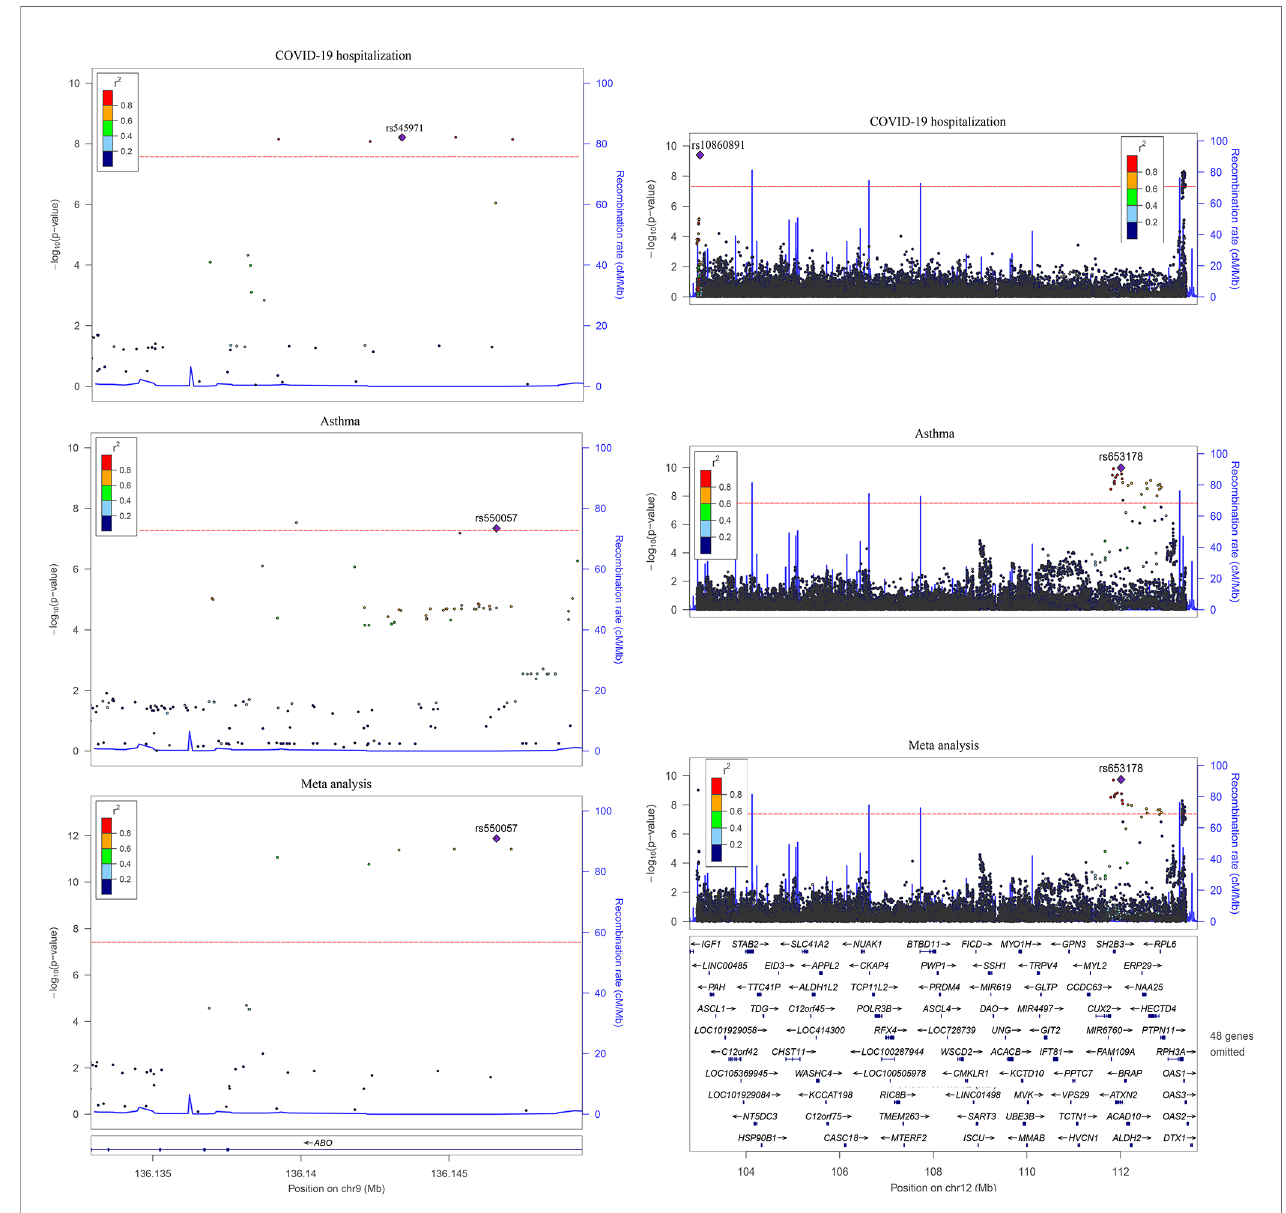
FIGURE 3 | Two overlapped loci between COVID-19 hospitalization and asthma. Left is the 9q34.2 locus and right is the 12q24.13 locus in hg19. The linkage disequilibrium information is from phase 3 of the 1000 Genomes Project. The dashed line represents the threshold for genome-wide signi fi cance (P <